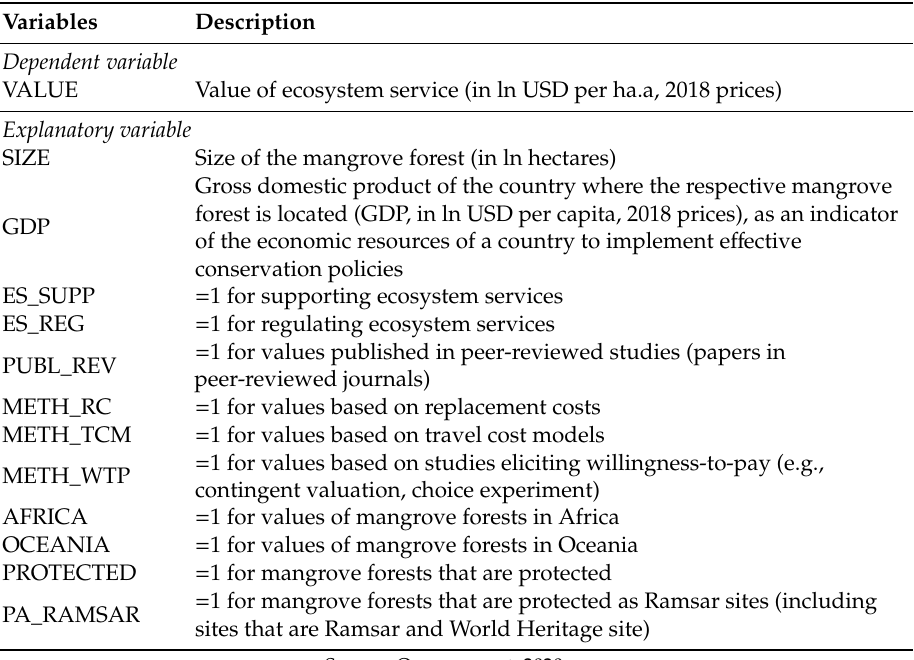
Table 4. Description of the dependent and explanatory variables of the estimations of the